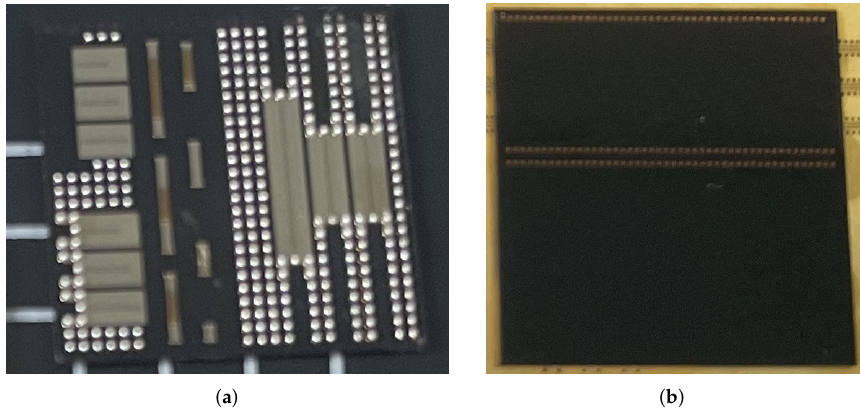
Figure 10. Photo of the fabricated sample of the FOWLP. ( a ) Front side. ( b ) Back side.